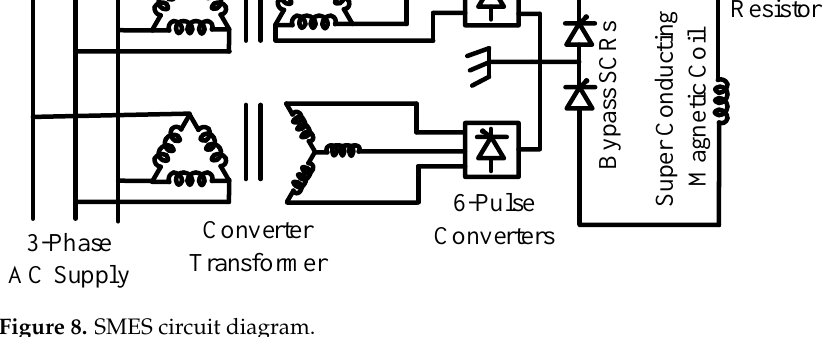
Figure 8. SMES circuit diagram. Figure 9. Transfer function-based circuit diagram of SMES.